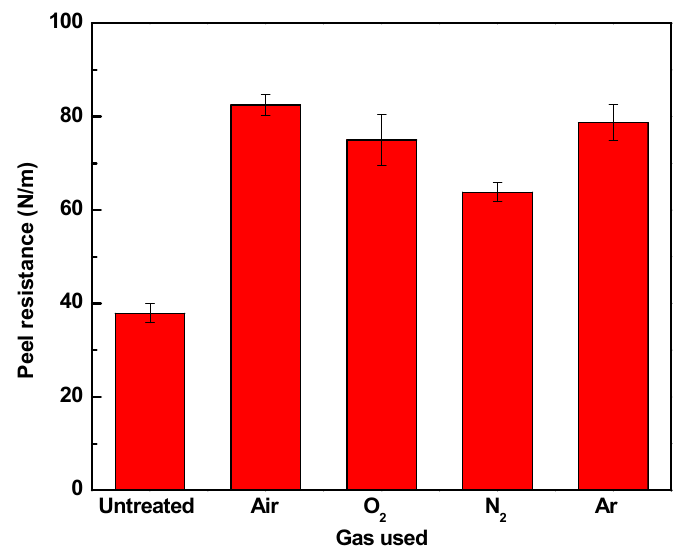
Figure 6. Peel resistance values of treated PU samples with different gases.